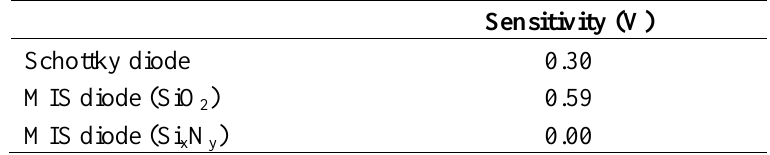
Table 2. Sensitivities of conventional Pt–GaN Schottky and MIS Pt–GaN diodes in 1% H in N extracted from Figures 1 and 5. Here, the sensitivities are defined as shifts in voltage 2 upon exposure to 1% H in N at a current of 0.1  A. Reproduced with permission from 2 2 Reference [17]. Copyright The Japan Society of Applied Physics.